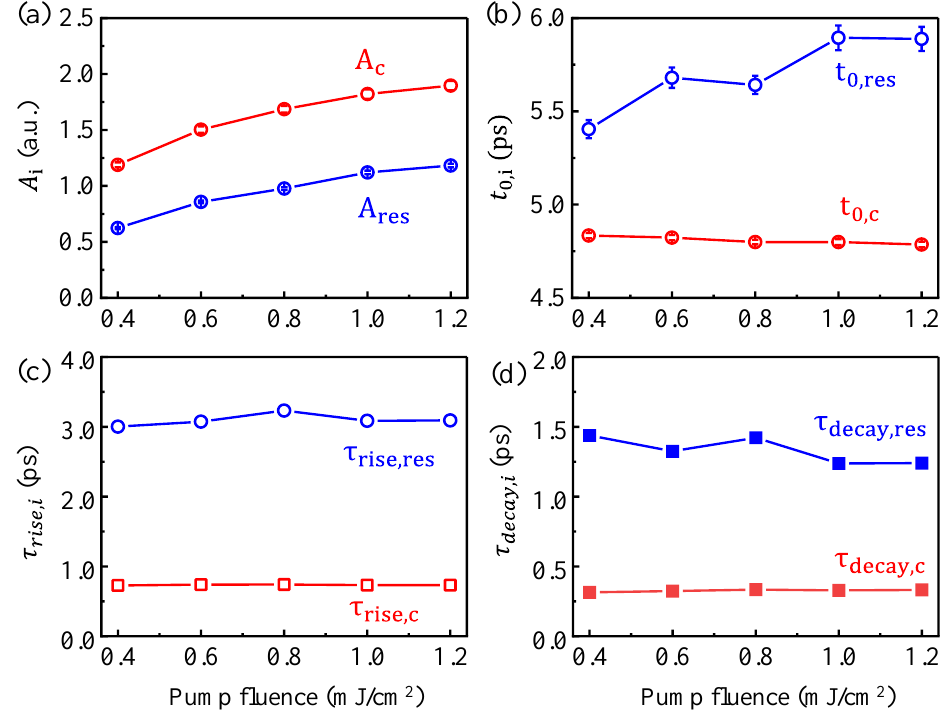
Figure 5. Pump fluence evolutions of ( a ) the amplitude and ( b ) time at peak of the j c ( t ) and j res ( t ) current profiles. Pump fluence-dependent ( c ) rise and ( d ) decay time constants of j c ( t ) and j res ( t ), respectively.